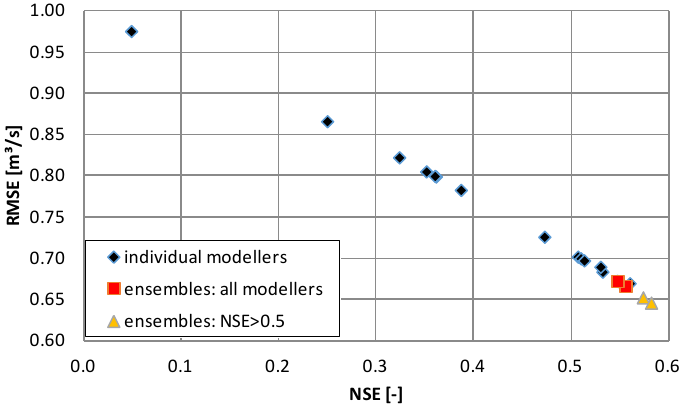
Figure 7. Comparison of individual model applications (blue diamonds) against model(er) ensembles (median, mean) based on all models (red squares) and on all models achieving satisfactory model results (yellow triangles) according to [25]. For graphical reasons, the results of one modeller are not shown who achieved an NSE value of − 45.9.